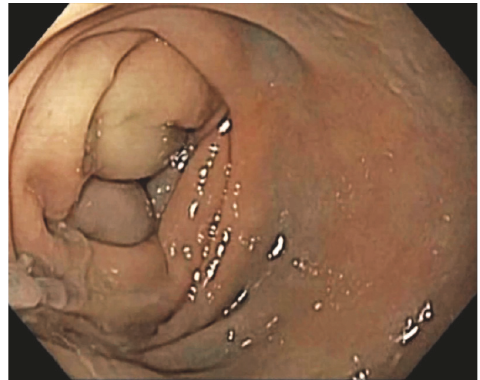
Figure10:Endoscopicimageshowinggeneralizedgutedemainapatientwithseverehypoalbuminemia.Theileocecalwallappearsedematous with a loss of mucosal vascular patterns.